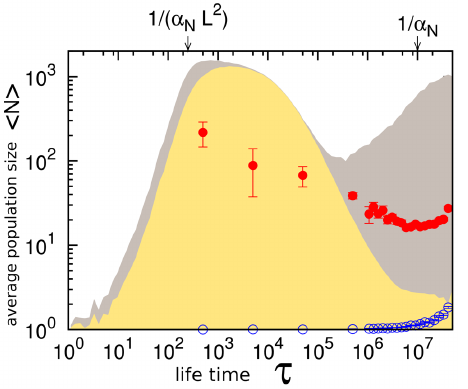
Figure 5. Time average of the population size. S N T is as a function of the life time, t , of a species (yellow) and as a function of the life time of all its descendants (red circles) in a system with L ~ 200 , a N ~ 10 { 7 , and E ~ 0 : 02 . The grey shadow indicates the maximum value of the population size reached by the species with the given life time. For t w 10 7 each site in the system has experienced at least one mutation event, whereas the first mutation in the system occurs at t & 250 . The open blue circles show the time averaged number of descendants, a number that grow beyond one for t w 10 7 . species develops quite gradually, one can notice that the population changes are intermittent. Remarkably, the lineage mostly persists in a stage with relatively few individuals. Figure 5 systematizes the population statistics of species and their families as a function of their life-time ( a N ~ 10 { 7 , E ~ 0 : 02 , and L ~ 200 ). Interestingly, the species that exist only for a rather short time ( 10 3 – 10 4 time units) are those whose population sizes are the largest. In contrast, the species that exist for sufficiently long time to allow speciation (blue circles) mostly have small population sizes. We emphasize that also the maximum popula- tion of a species is declining when its total existence time becomes long (data not shown). Instead, the red circles depict the average population size, N , of the whole lineage starting with a single species. Again, one can observe a decline in population as survival time is longer, a pattern that is also consistent with the case story plotted in Fig. 4.